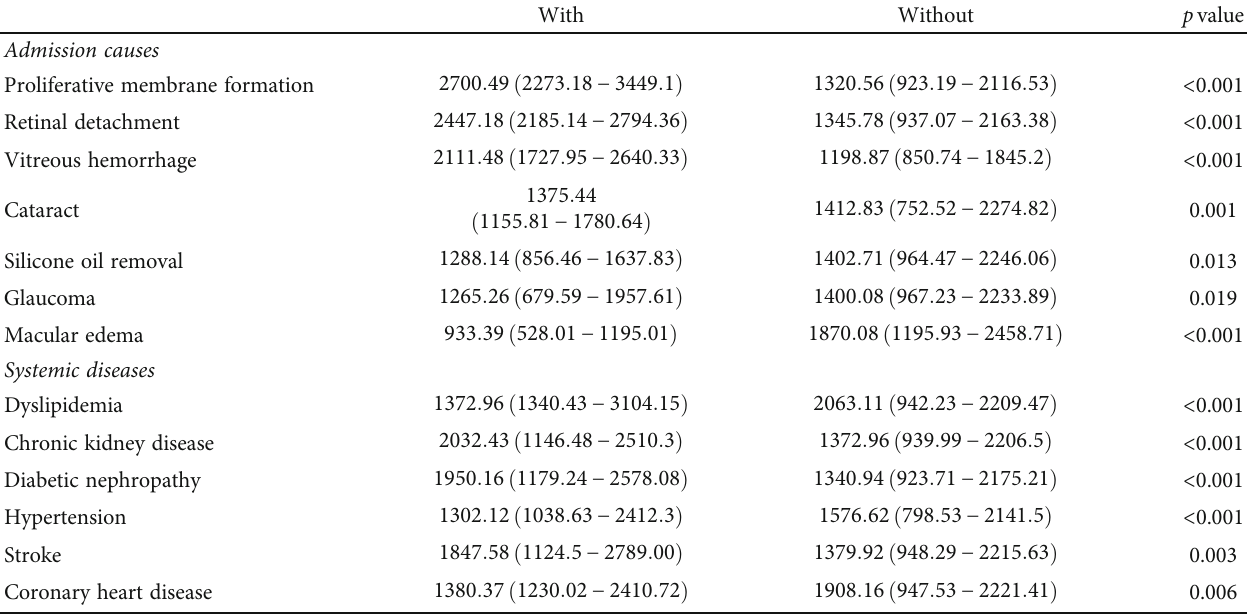
Table 5: Comparison of hospitalization cost in DR patients with or without di ff erent admission causes and systemic diseases. With Without p